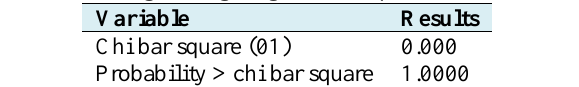
Table 6. Breusch & Pagan Lagrangian multiplier check for REM